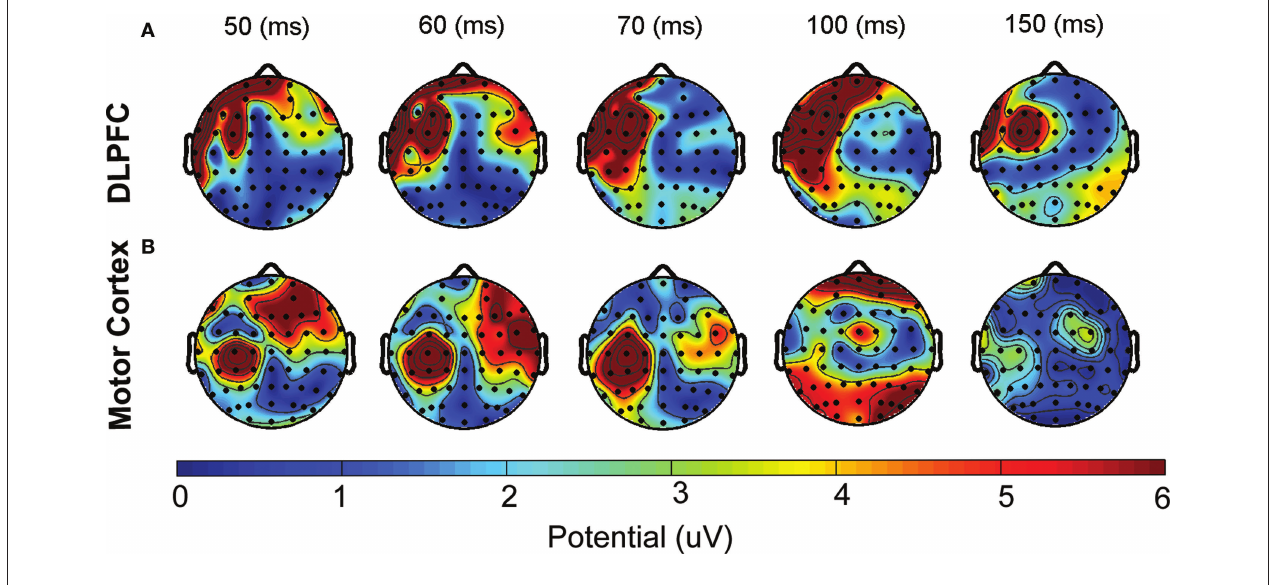
subjects. These plots suggest that, application of TMS to the left hemisphere results in activation of regions on the contralateral hemisphere but the activity is lower than that of the ipsilateral hemisphere. Topographic head plots were obtained by EEGLAB toolbox (Delorme and Makeig